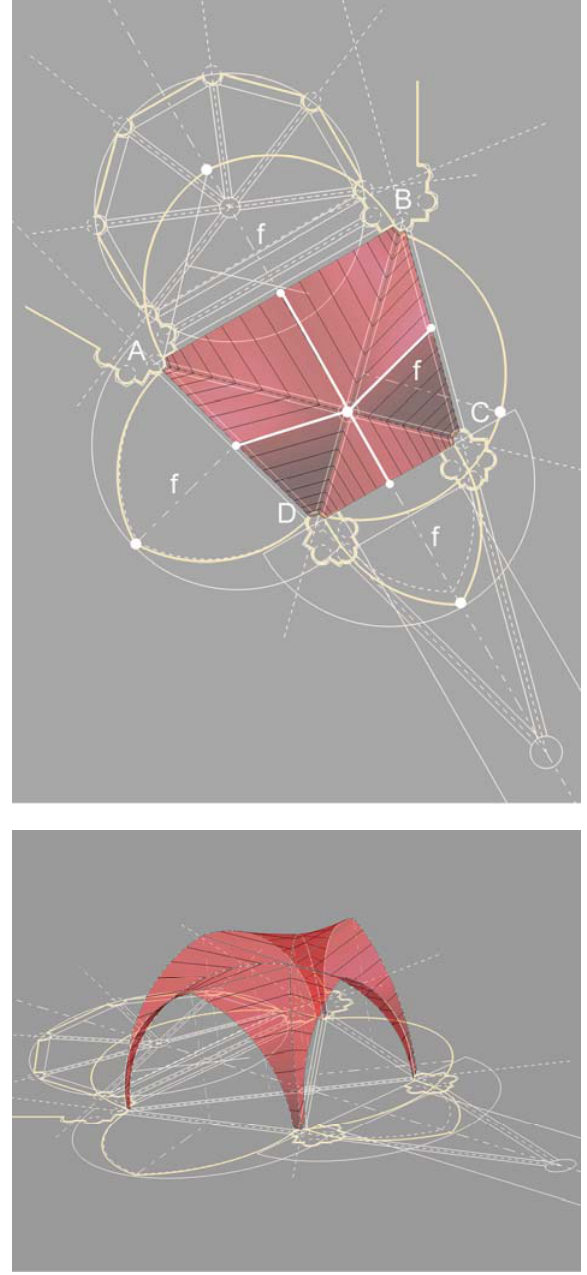
Figure 10. S. Lorenzo, 3D Geometry model from theoretical hypotheses